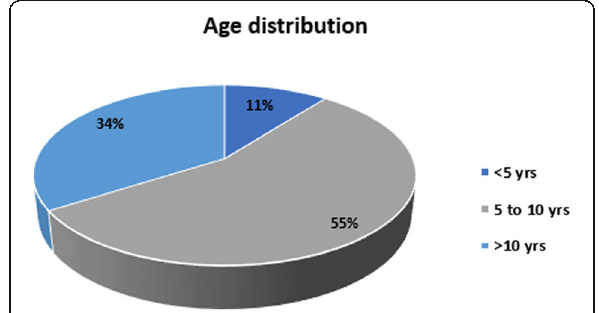
Fig. 1 Age distribution of